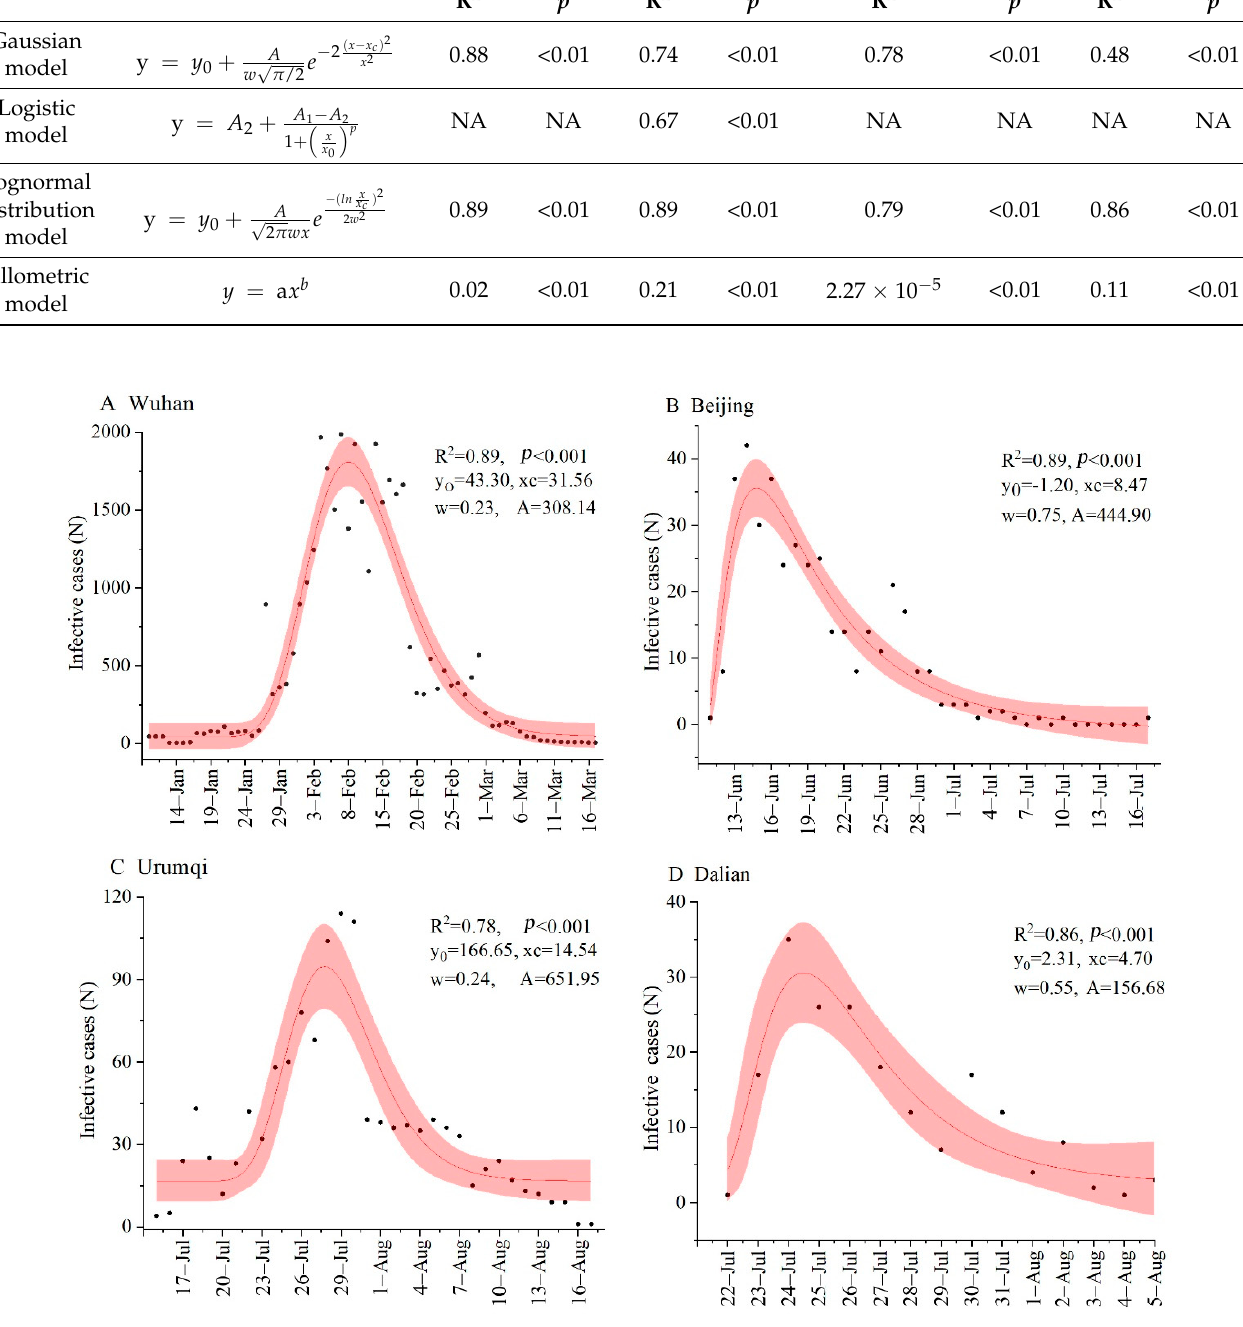
Figure 2. The fitting curve of COVID-19 infected cases using the lognormal distribution model in four Chinese cities ( A – D ). The fitting effect of the lognormal distribution model to the infected cases was better in Wuhan (R 2 = 0.89, p -value < 0.001) and Beijing (R 2 = 0.89, p -value < 0.001) than in Dalian (R 2 = 0.86, p -value < 0.001) and Urumqi (R 2 = 0.78, p -value < 0.001). This indicated that the fitting accuracy of the lognormal distribution model on COVID-19 infected cases varied among cities. Dalziel et al. [41] and Soebiyanto et al. [42] considered that the fitting accuracy of the pandemic model may be related to virus transmission pattern. Differences in population